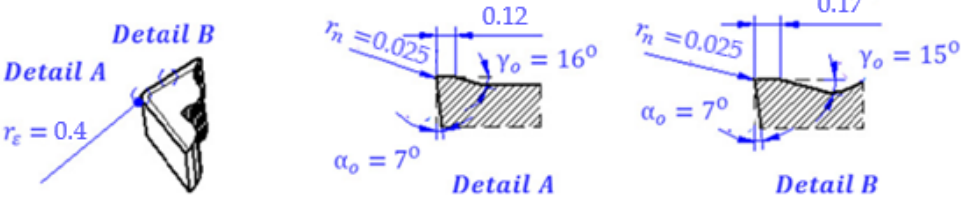
Figure 1. Coated carbide tool configuration. Reprinted with permission from ref. [18]. Copyright 2021 Elsevier. Measurements in